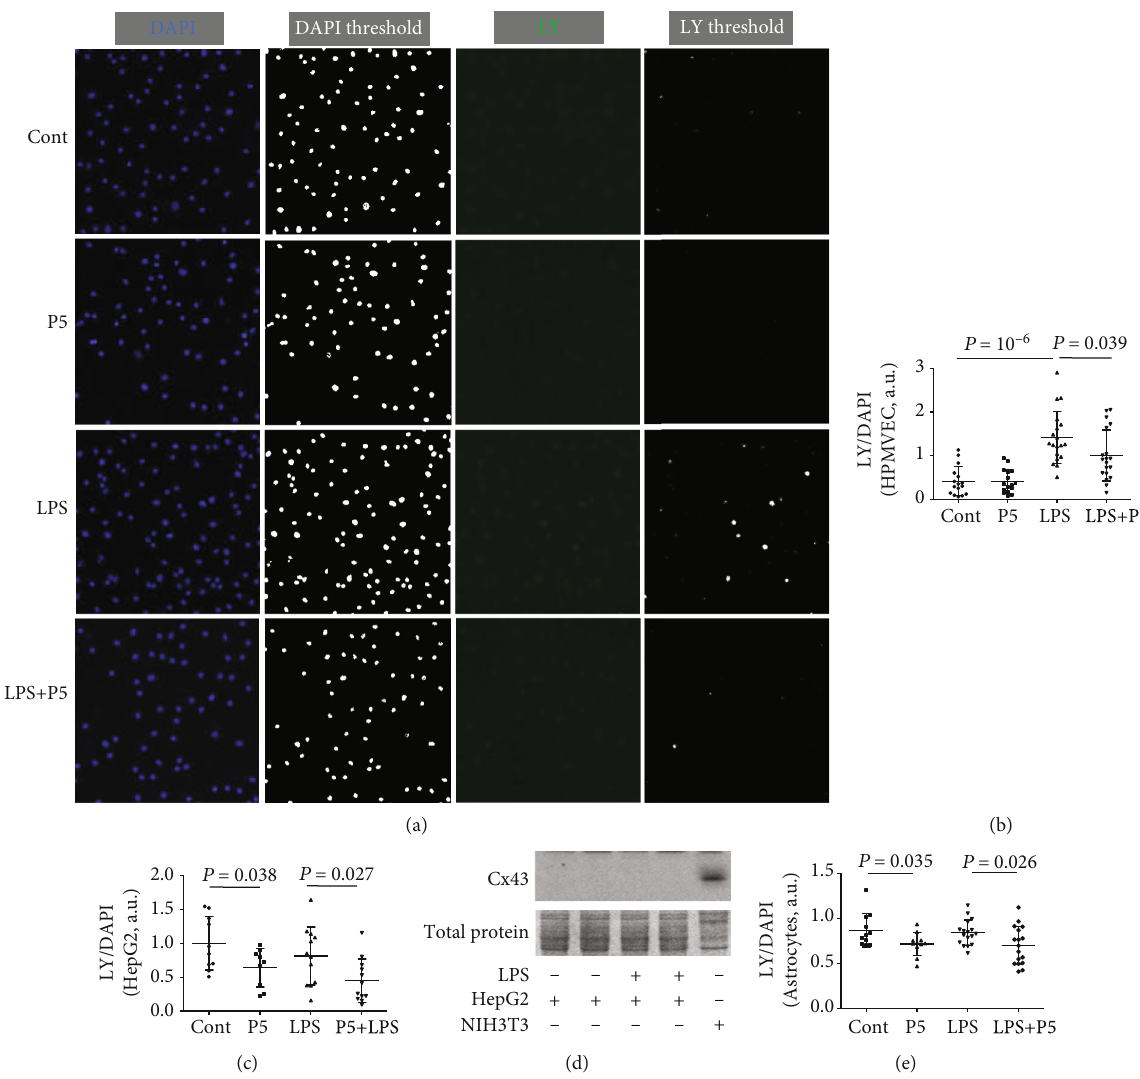
Figure 1: Cx43 mimetic peptide P5 inhibited LY uptake in vitro . HPMVEC (a, b), HepG2 (c), and Cx43-de fi cient cell (e) cultures were divided into Cont (saline), P5 (20 μ g/ml), LPS (0.5 μ g/ml), and LPS+P5 (0.5 μ g/ml LPS+20 μ g/ml P5) groups. LY was applied to the culture medium for 10 min incubation. Then, cells were fi xed with paraformaldehyde and stained with DAPI. The ratio of LY/DAPI fl uorescence signals was used to determine HC permeability. The unit of the LY/DAPI ratio is arbitrary, and the values are not comparable between experiments using di ff erent cells. (d) Expression of Cx43 in HepG2 and NIH3T3 cells with or without LPS challenge was examined using Western blotting. a.u.: arbitrary